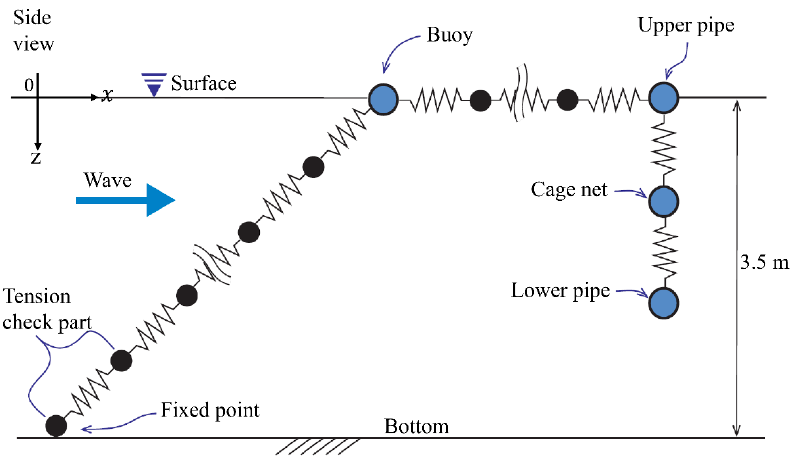
Figure 5. The cage system modeled by a simplified mass-spring model.